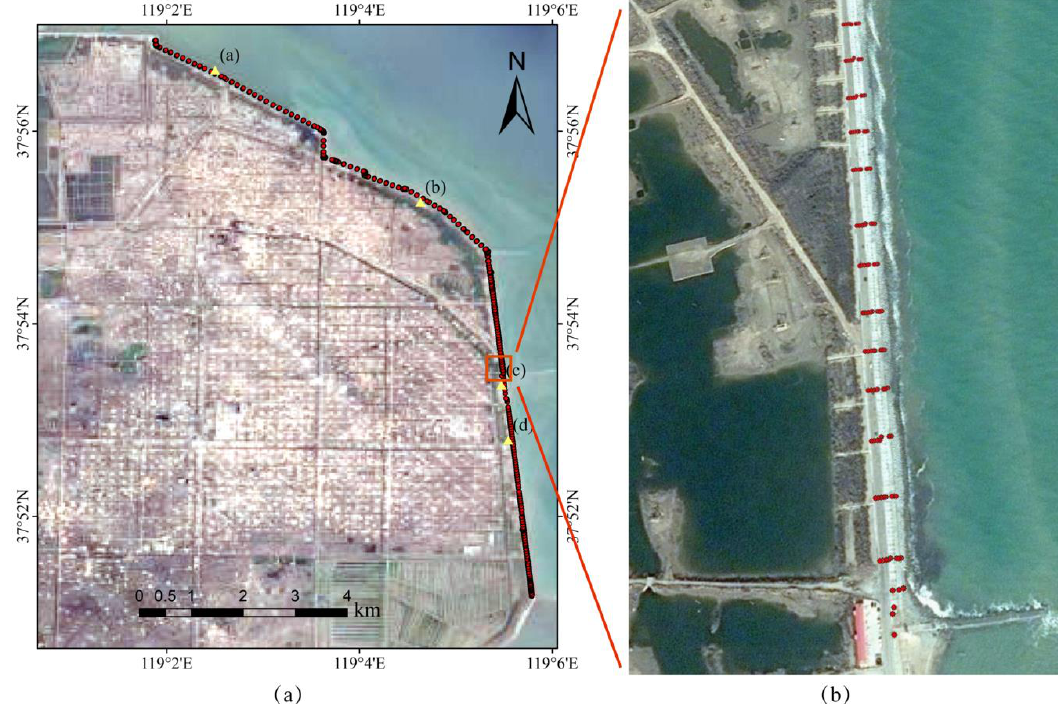
Figure 9. ( a ) The distribution of all detail points collected by GNSS RTK along Gudong Dam; ( b ) typical presentation of detail points.